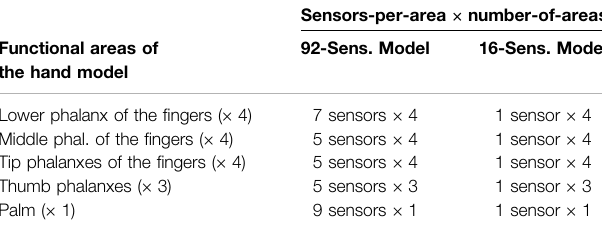
TABLE 2 | The 92 and 16 Touch-Sensor Environments . Sensors-per-area × number-of-areas Functional areas of the hand